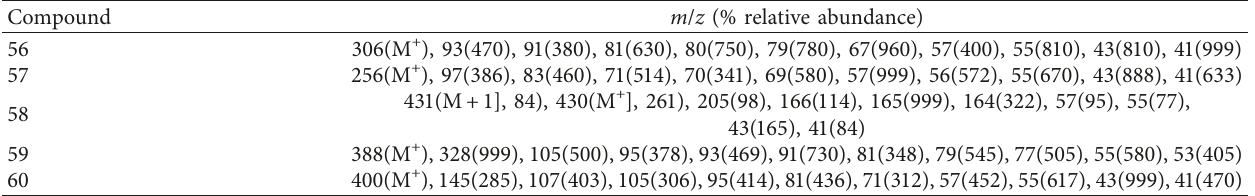
Table 26: Mass spectra of compounds 56–60 of whole plant n -hexane fraction of Achillea wilhelmsii (WHFAW).